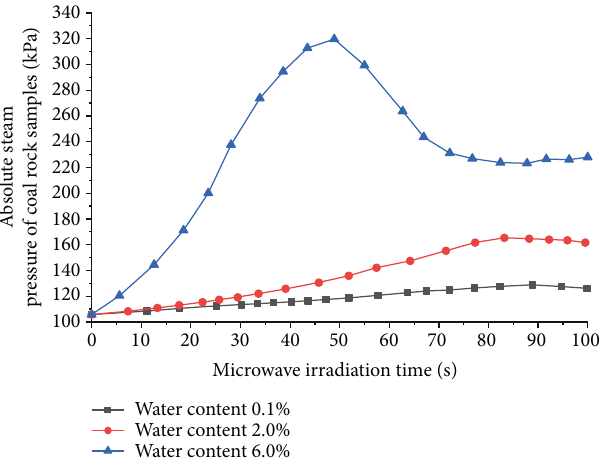
Figure 6: Changes in the internal absolute gas pressure with time of coal rock samples with di ff erent water contents.